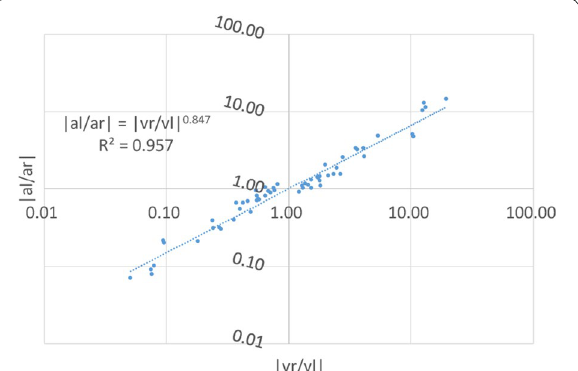
Fig. 7 Slip parameter n identified on a rigid floor